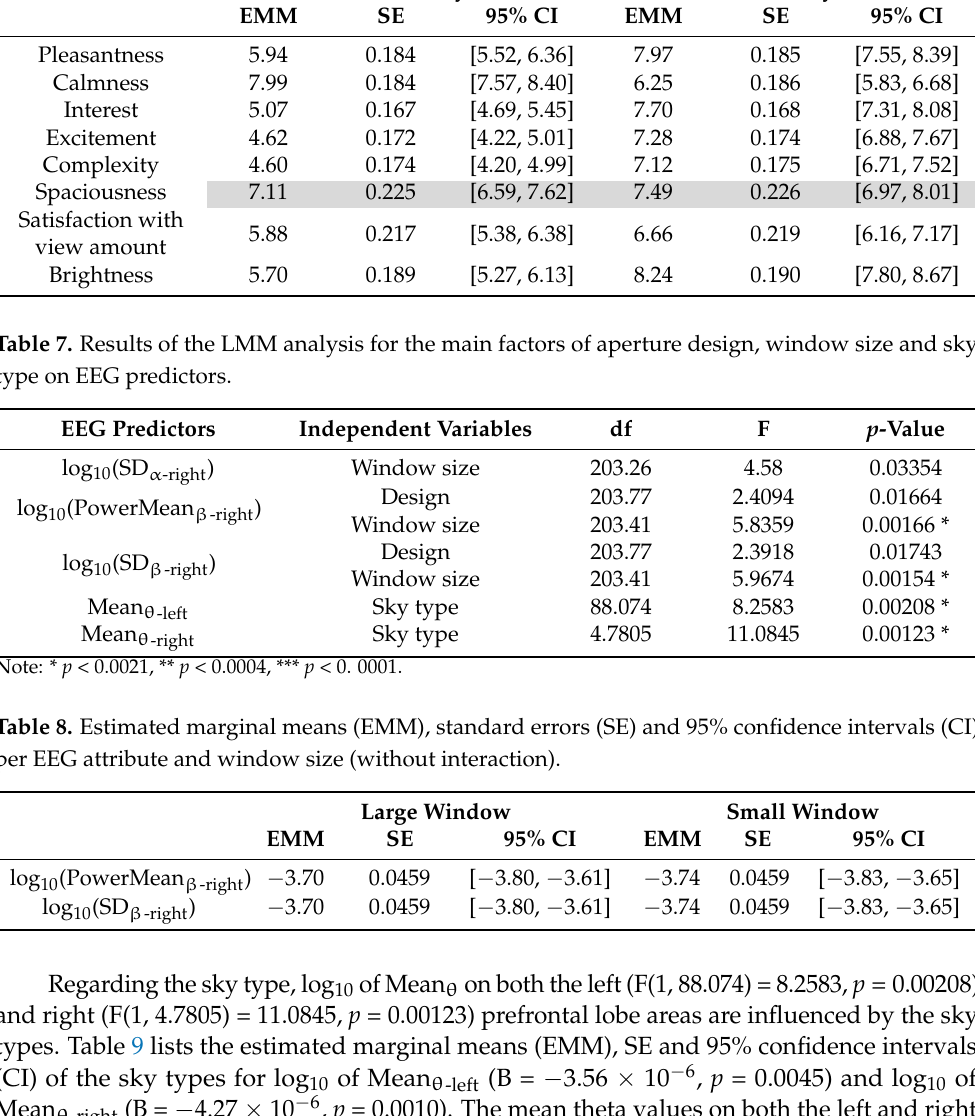
Table 6. Estimated marginal means (EMM), standard errors (SE), 95% confidence intervals (CI) for all eight dependent variables, along with the estimates B and standard errors (SE) for pairwise comparisons. Overcast Sky